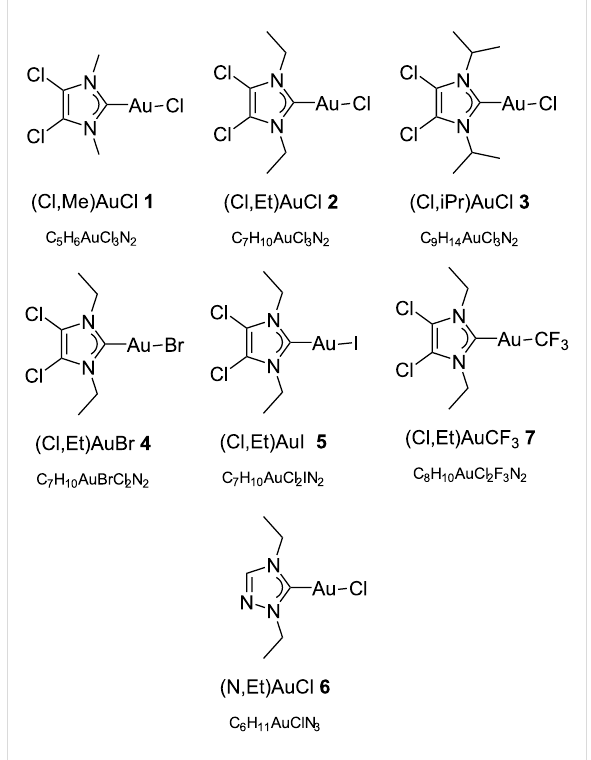
Figure 3: The selected Au(NHC)X complexes studied and their molec- ular formulae.